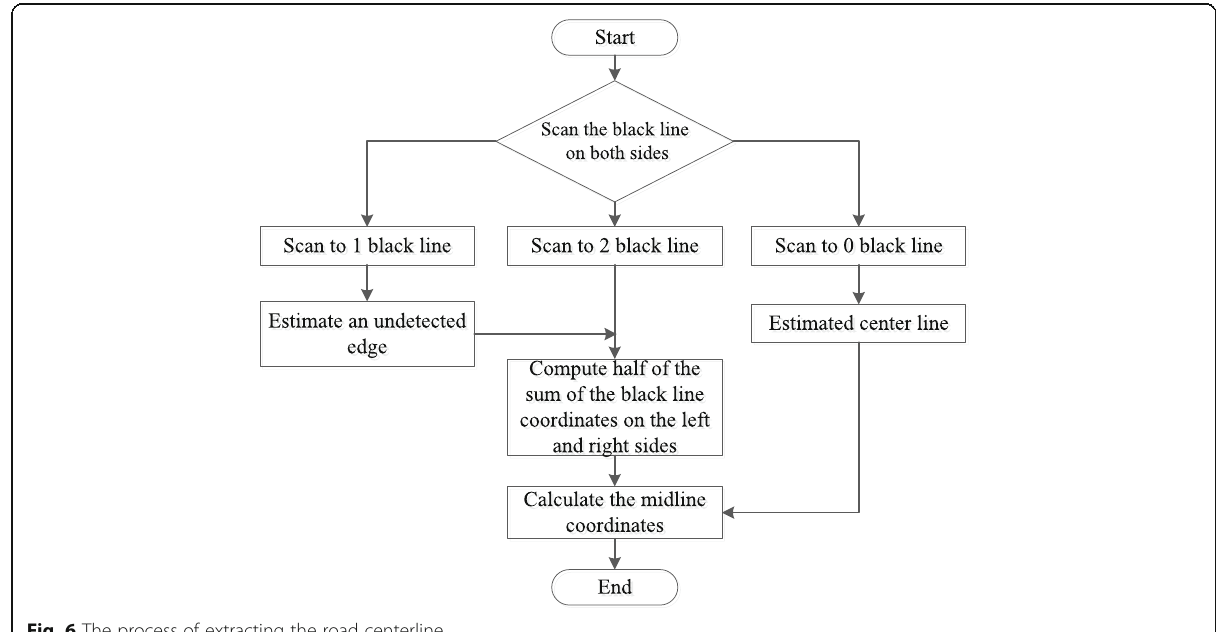
Fig. 6 The process of extracting the road